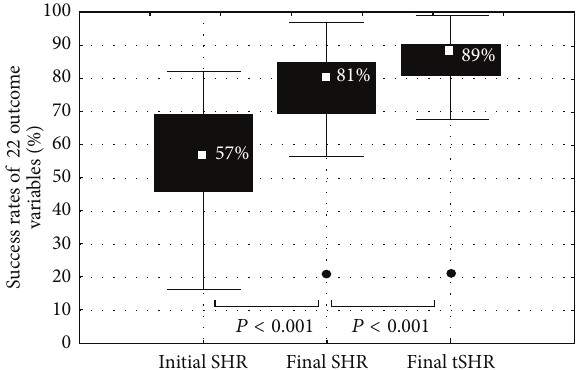
Figure 3: The figure shows the distribution of the success rates of 22 outcome variables (SHR) with the median value (central dot), quartile range (box) and range